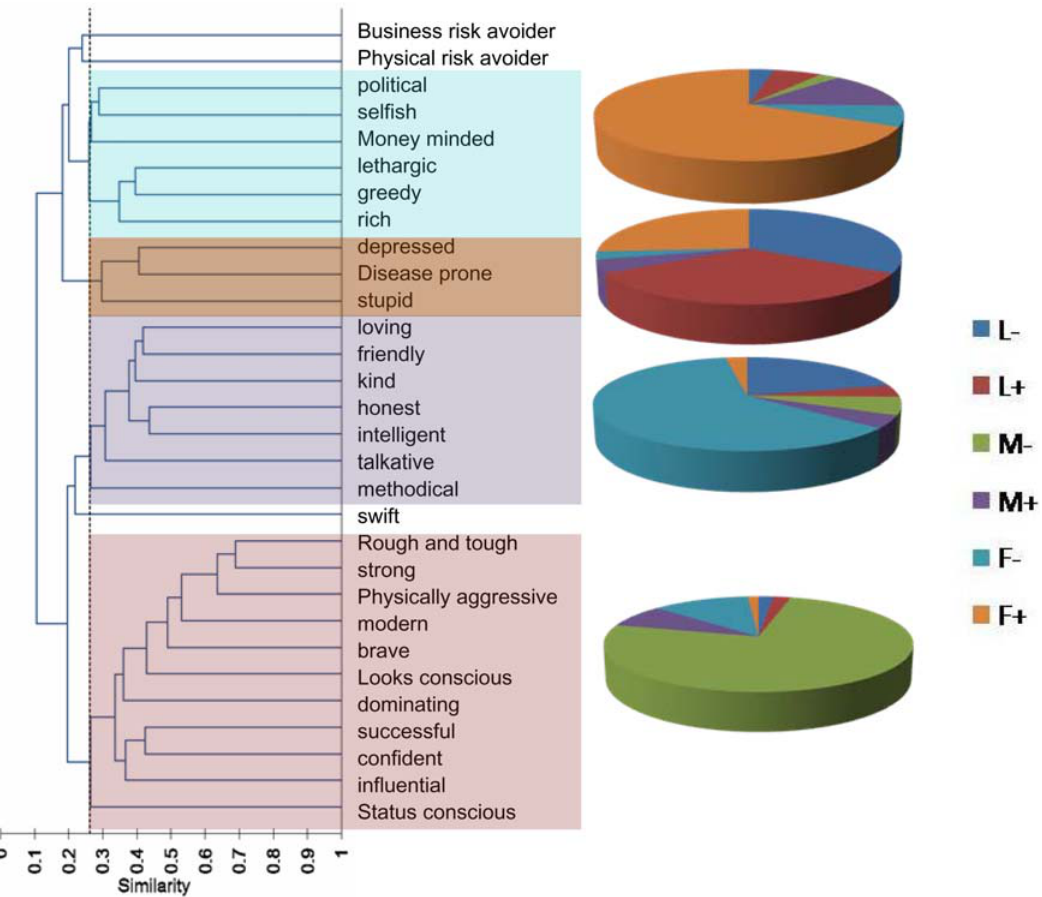
Figure 2. Clustering of personality traits based on the similarity matrix (table 2): Four distinct clusters emerged using the significance level of individual pair (alpha=0.05) as the cut-off. The four clusters were dominated by different body forms as shown in the pie-charts.